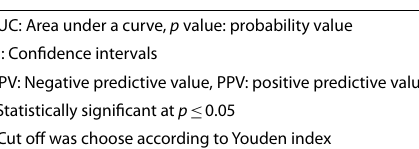
AUC: Area under a curve, p value: probability value